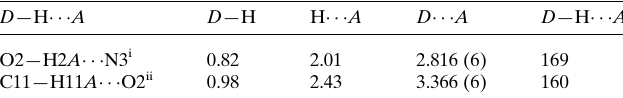
Table 1 Hydrogen-bond geometry (A˚ , (cid:3)